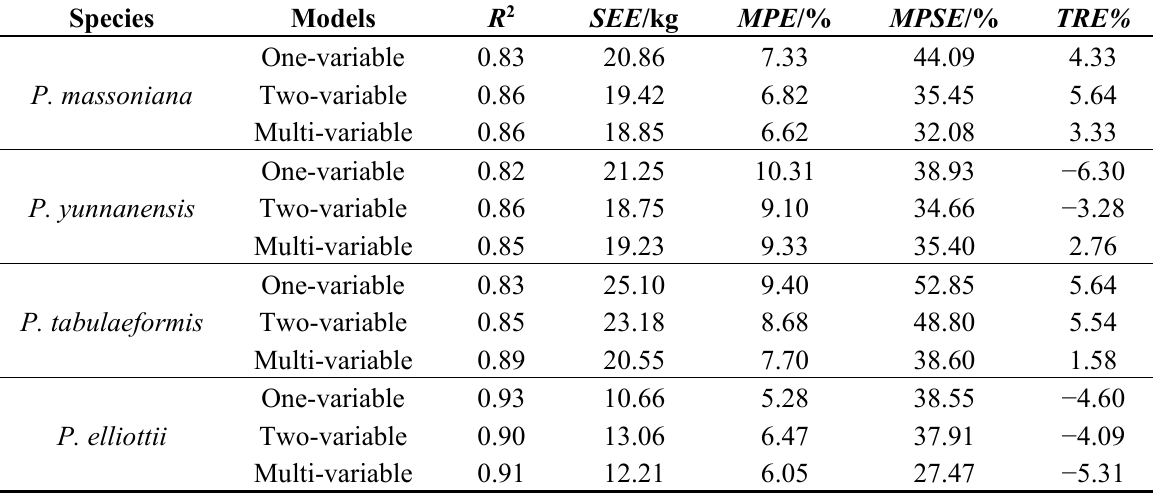
Table 5. The statistics of nonlinear mixed-effects models for species-specific crown biomass estimation.